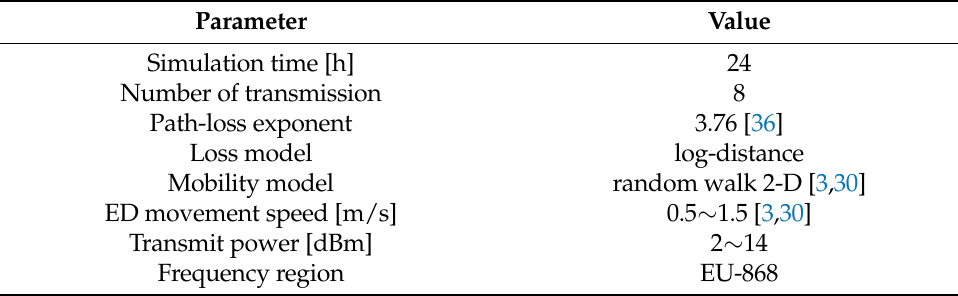
Table 2. Parameters used in the simulation study.